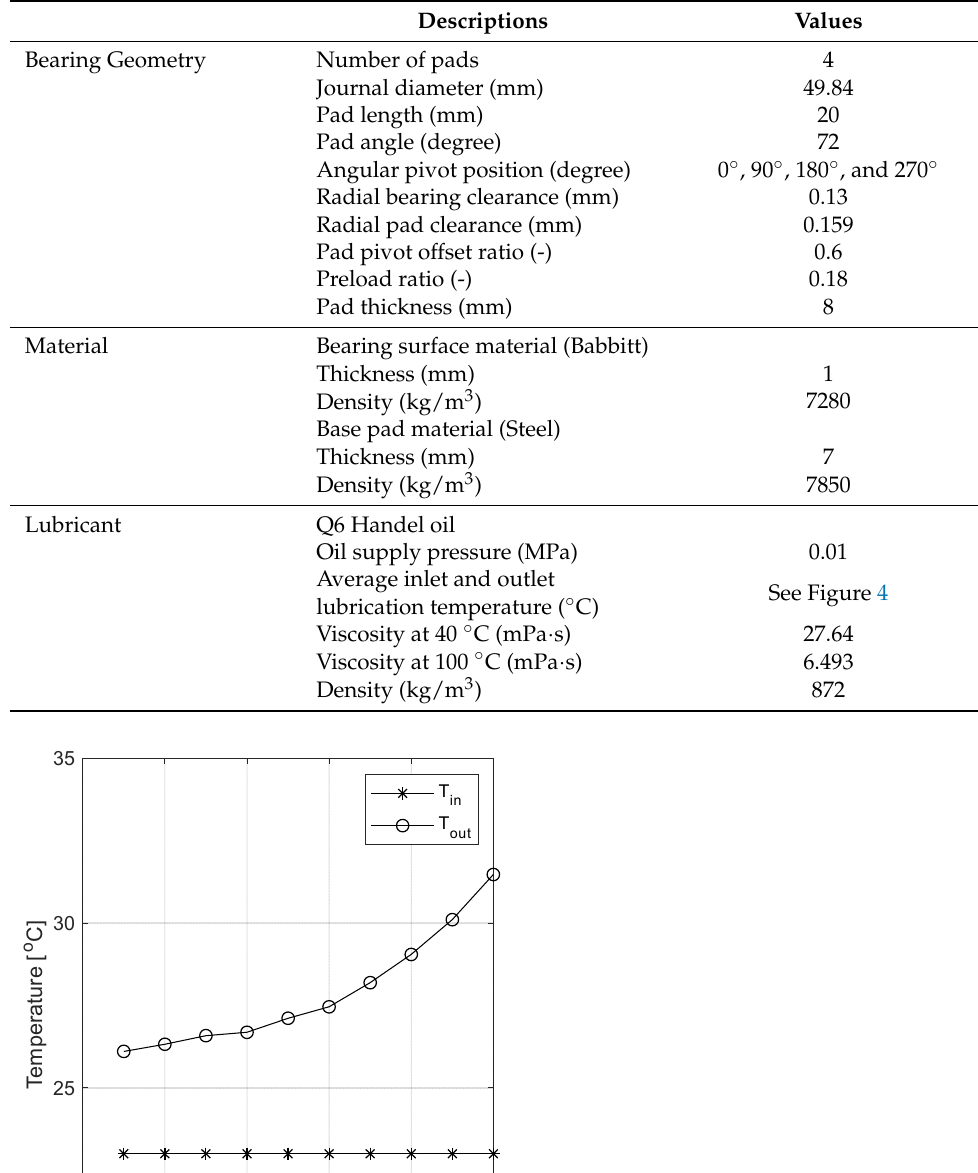
Table 2. Technical specification of the four-shoes TPJB.